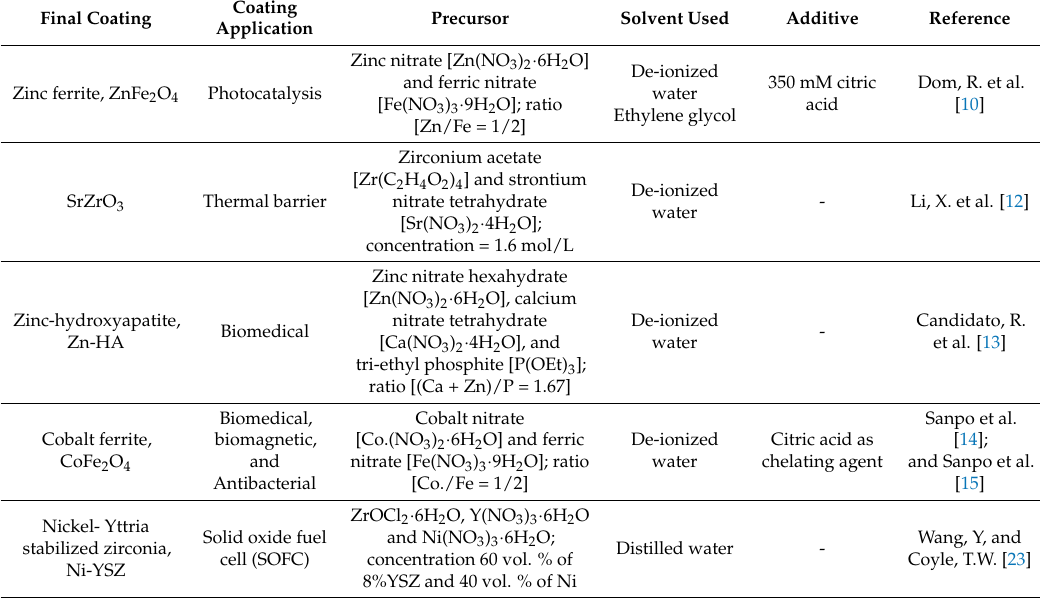
Table 1. Solution precursor preparation for cermet coating fabrication via SPPS.